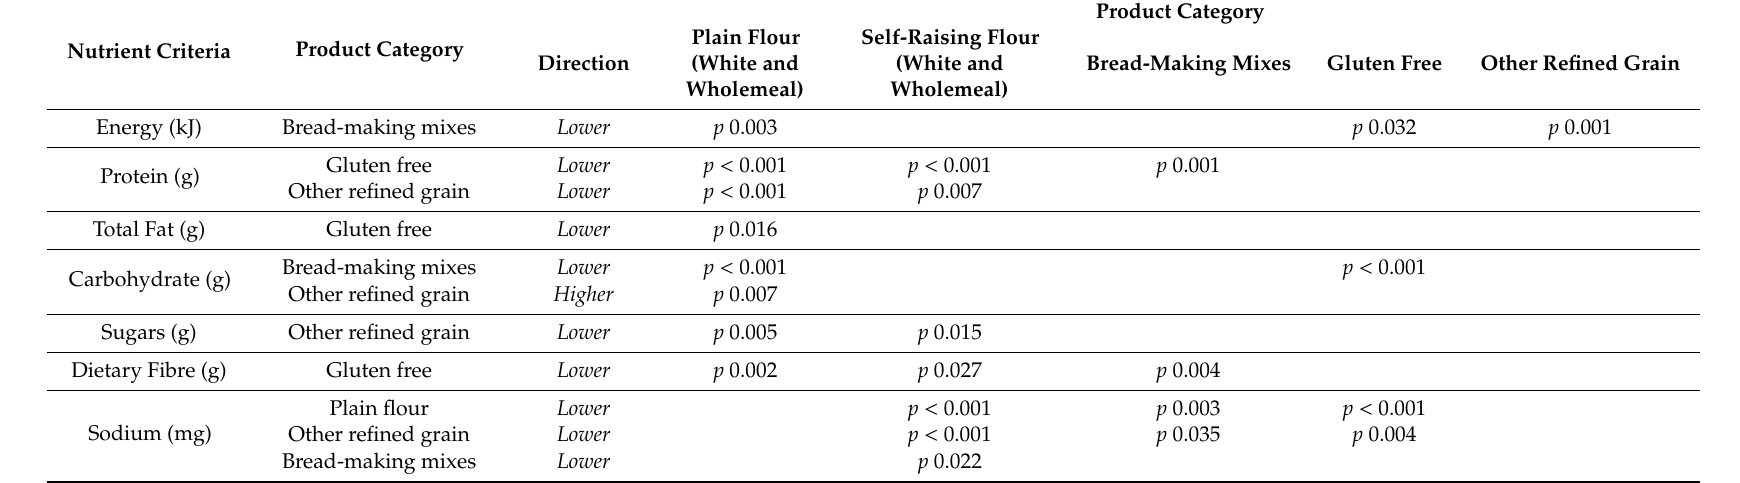
Table A1. Grain-based flours post hoc comparison p values (CI